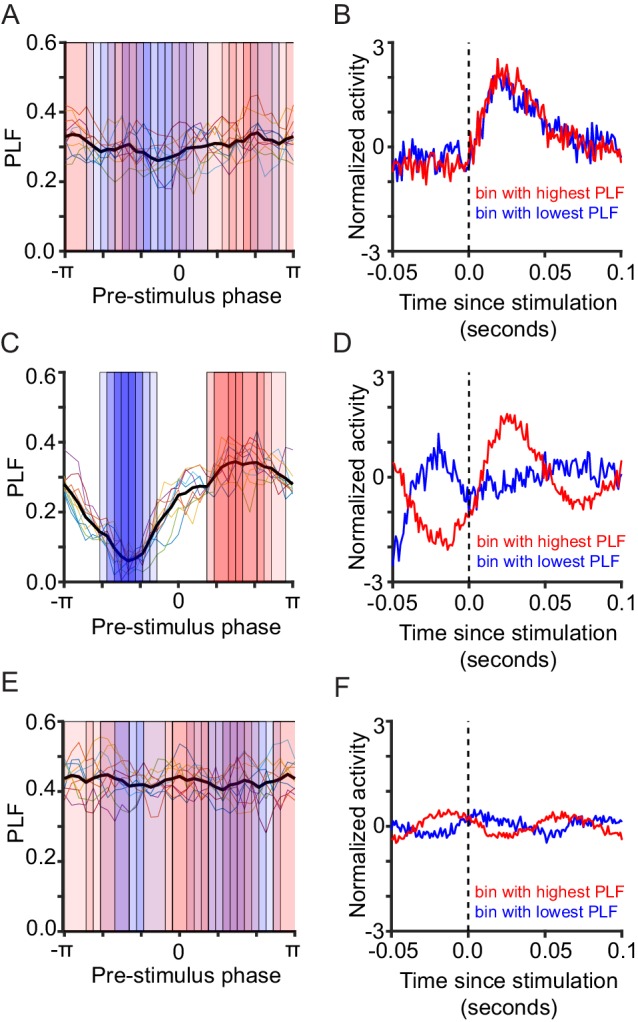
Critical networks show maximal phase-locking response on the rising side of the alpha oscillation, and minimal phase-locking response on the falling side of the alpha oscillation.We ran 10 network initializations for the same 3 parameter combinations used throughout the paper (subcritical A,B, critical C,D, supercritical E,F). For each run we binned the trials in 32 bins based on the pre-stimulus phase at -5 ms, and computed the PLF at 150 ms for each bin. (A,C,E). Each individual colored line corresponds to the PLF distribution across phases for one of the 10 simulations. The black line represents the average across all 10 simulations. As shown before, the pre-stimulus phase regulates the post-stimulus response only for critical networks. For each simulation run, we highlighted the phase bin showing the highest PLF with a red rectangle, and the phase bin showing the lowest PLF with a blue rectangle. The bins with highest/lowest PLF are roughly the same across trials for critical networks (C), but highly spread out for sub/supercritical networks (A,E). (B,D,F) The pre-stimulus phase is calculated on the signal filtered using a one-way filter, which induces a phase shift of 125 ms. To resolve the phase of the oscillation right before the stimulation, we computed, for each of the 10 simulations, the average of the network signal (unfiltered), across trials belonging to the phase bin with the highest PLF (red) and the phase bin with the lowest PLF (blue). We included in our analysis stimulation trials from all 10 simulations. To isolate variation in pre-stimulus phase from the baseline level of activity, which differs between sub/super/critical networks, we standardized the data. We subtracted from the average across simulation runs, the mean of activity calculated between -50 and 0 ms, and then we divided by the standard deviation of the activity from the same time interval. For critical networks (D), there is a clear differentiation: on trials where the phase-locking response is strongest (red), the stimulus arrives half-way through the rising side of the alpha oscillation (where the phase is approximately 0). On trials where the phase-locking is weakest (blue), on the other hand, the stimulus arrives half-way through the falling side of the alpha oscillation (where the phase is approximately π). Subcritical and supercritical networks do not show such a clear differentiation, thereby illustrating that pre-stimulus phase regulation of stimulus response requires critical-state dynamics.